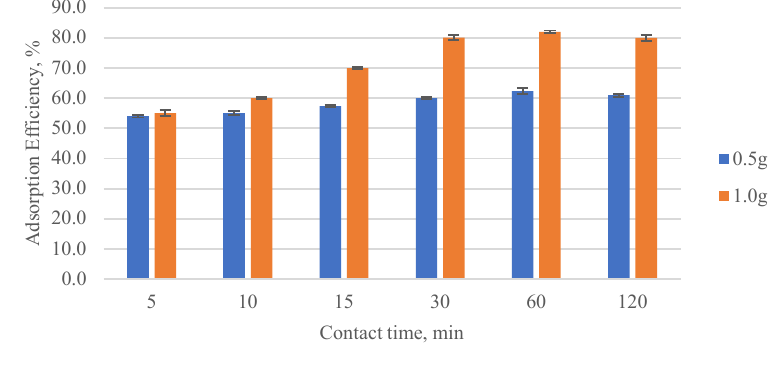
Fig. 2. Influence of contact time on copper (II) ions adsorption efficiency using modified wheat bran as adsorbent, n = 3, ±SD. It was discovered (Fig. 3) that with an adsorbent mass of 0.5 g the uptake of copper ions in